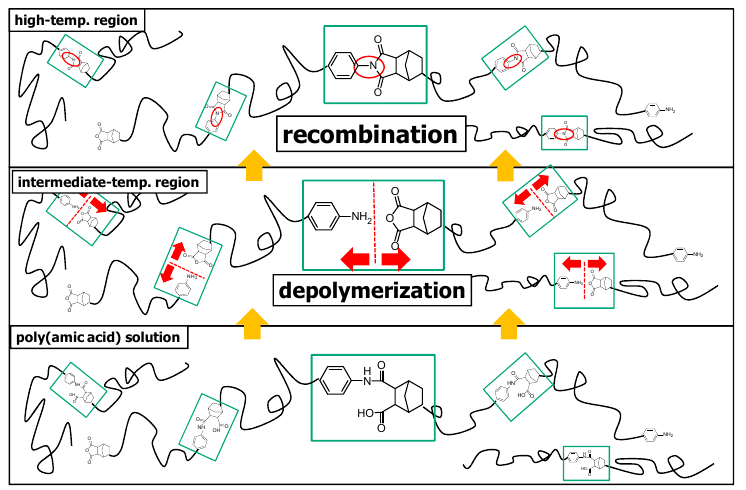
Figure 3. An imaginary depiction of depolymerization in the intermediate-temperature region and post-polymerization around Tg.